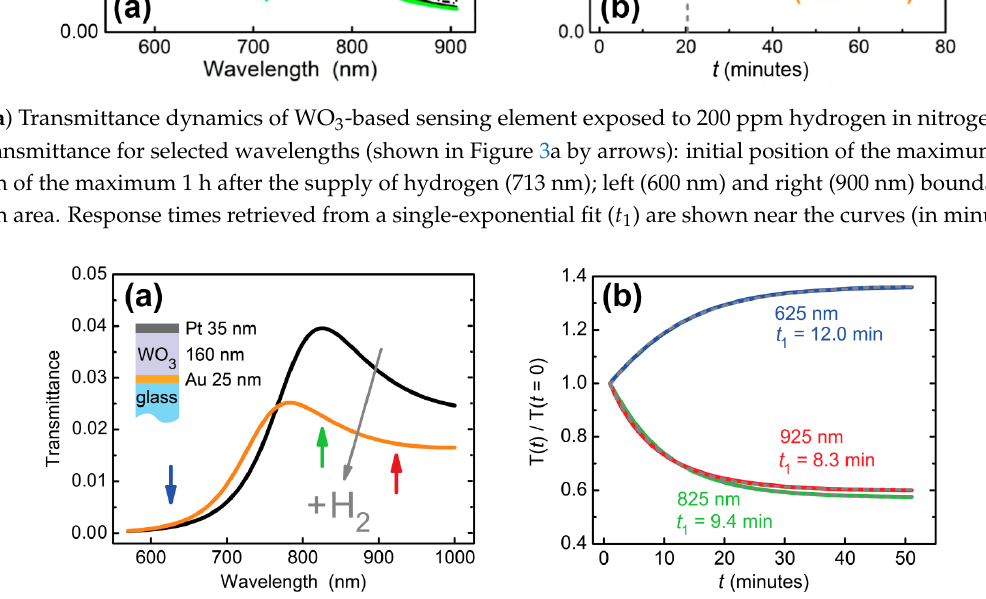
Figure 4. Calculated transmission dynamics of an Au (25 nm)/WO 3 (160 nm)/Pt (35 nm) trilayer. ( a ) Transmittance before and after hydrogen supply. ( b ) Transmittance at a given wavelength as a function of time. Refractive index changes of Pt were neglected for the purpose of illustration of response time variations due to two resonance in a dielectric WO 3 layer. Exponential decay times ( t 1 ) at different wavelengths are indicated next to the curves .